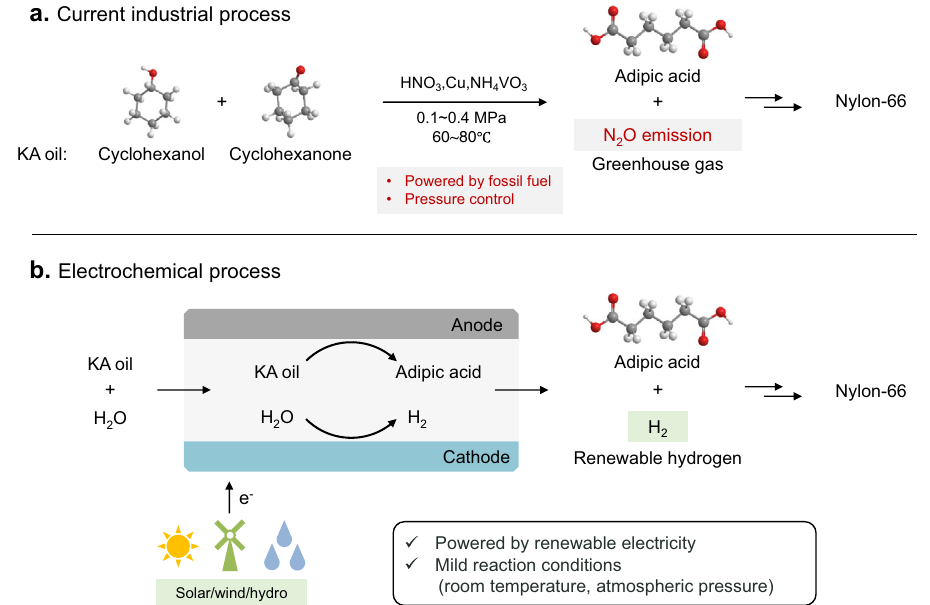
Fig. 1 | Schematic illustration of the KA oil oxidation to produce adipic acid. a Current industrial route. b Proposed electrochemical